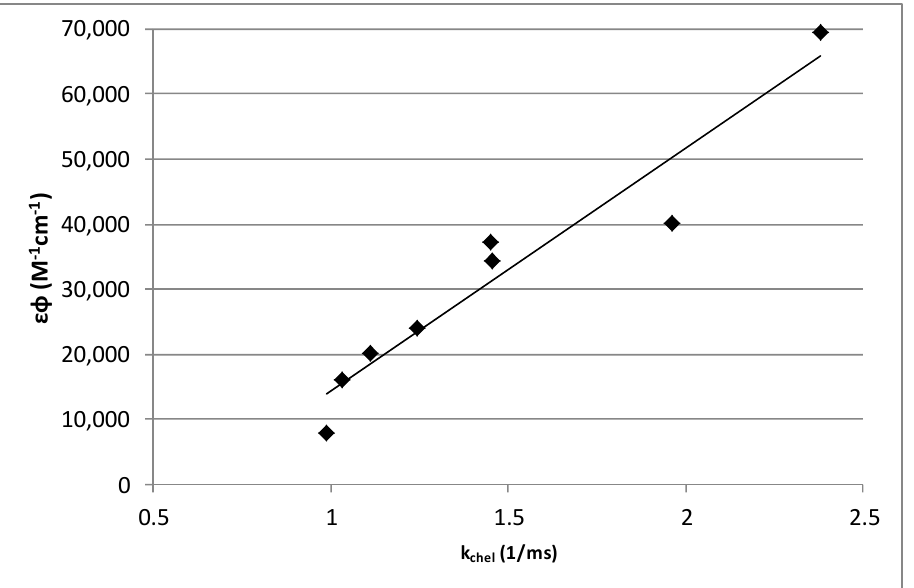
Figure 2. Measured enhanced brightness of chelates 1b – 8b on the dried surface vs. decay constant (k chel = 1/ τ ) measured in 0.05 M TRIS buffer.